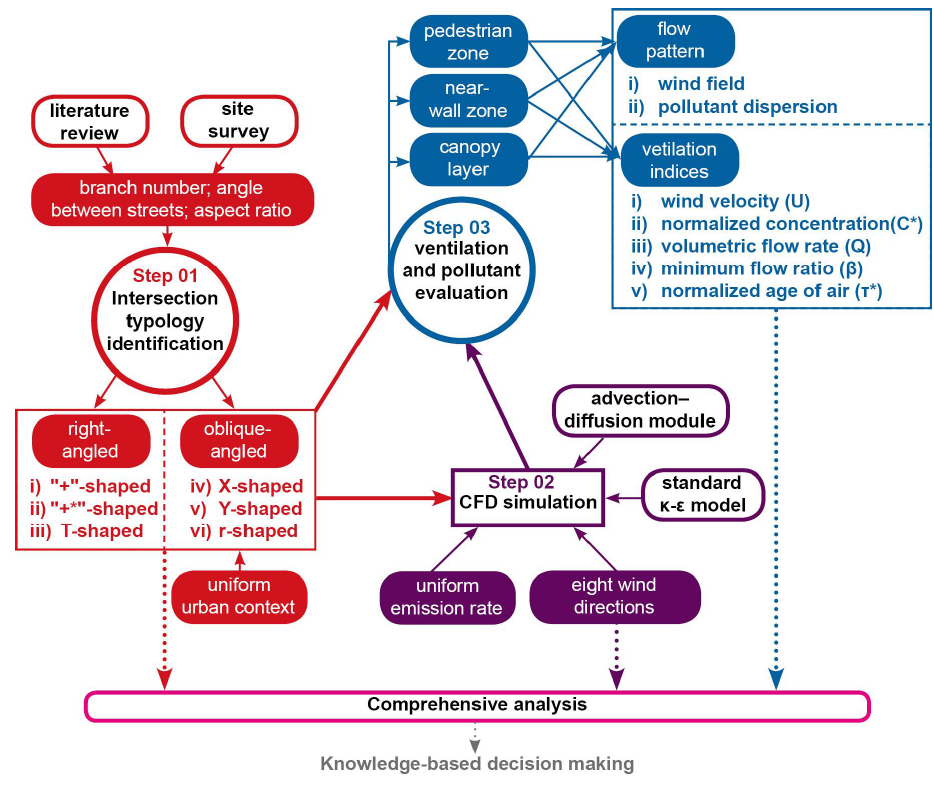
Figure 1. Methodology flowchart showing the major steps in this study: the main aspects are shown in solid shapes, and the methods in wireframed shapes. in solid shapes, and the methods in wireframed